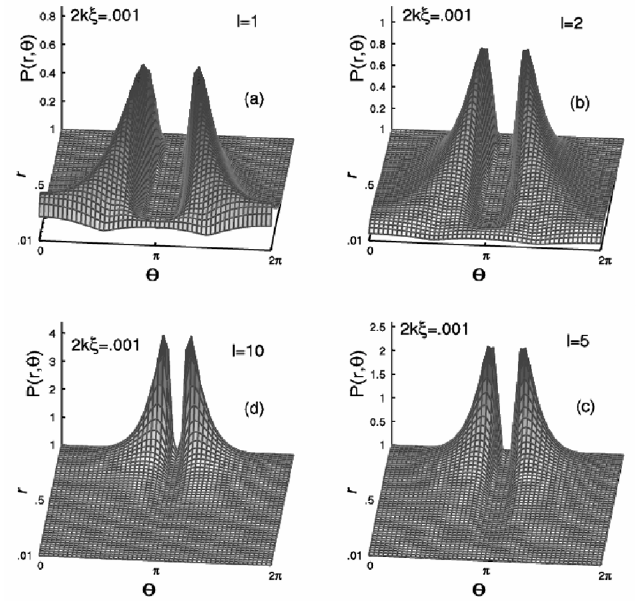
Figure 4. Evolution of the probability P ( r , θ ) with the sample length l (= L / ξ ) in the strong disorder regime for a fixed disorder strength parameter 2 k ξ = 0.001. Plots are for sample lengths ( a ) l = 1, ( b ) l = 2, ( c ) l = ( b ) l = 2, ( c ) l = 5, and ( d ) l = 10. 5, and ( d ) l = 10. Figure 5a (cid:48) –c (cid:48) are corresponding marginal distributions P ( θ ) of the phase θ when